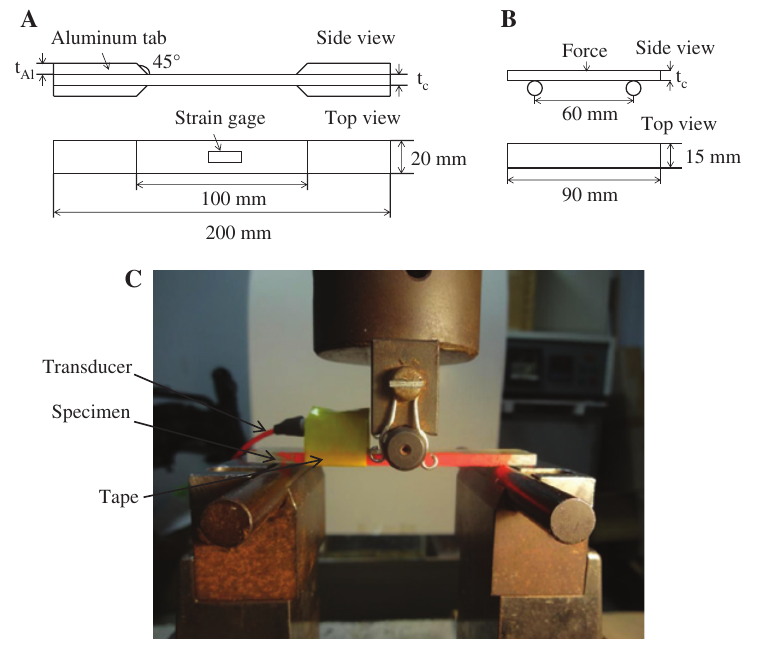
Figure 2 Geometry of the specimen: (A) tensile test, (B) three-point bending test, and (C) test set-up of specimen for the three-point bending